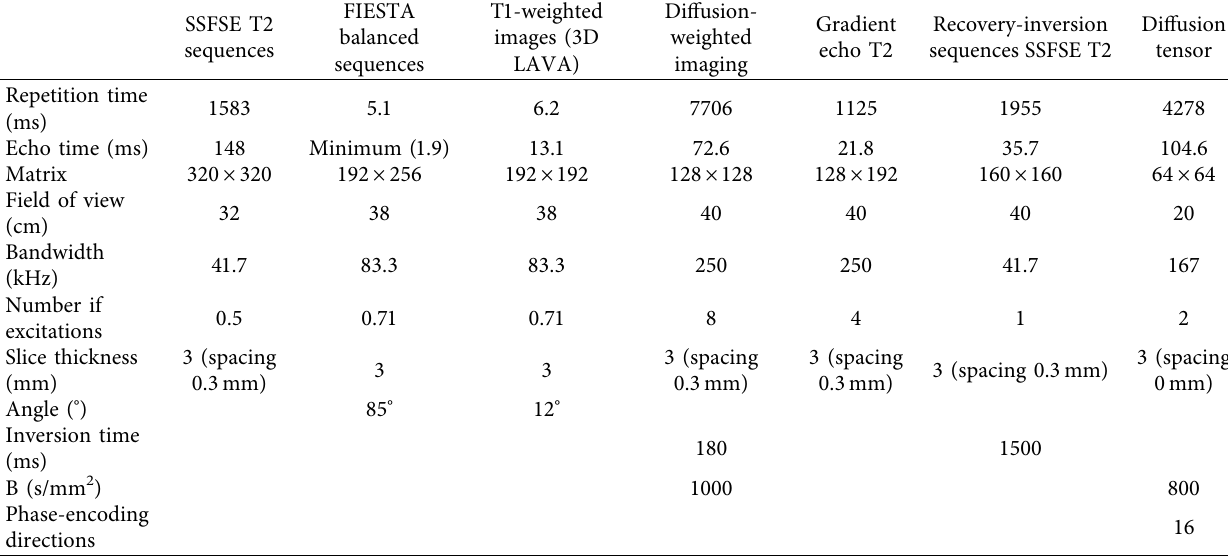
Table 1: Sequence